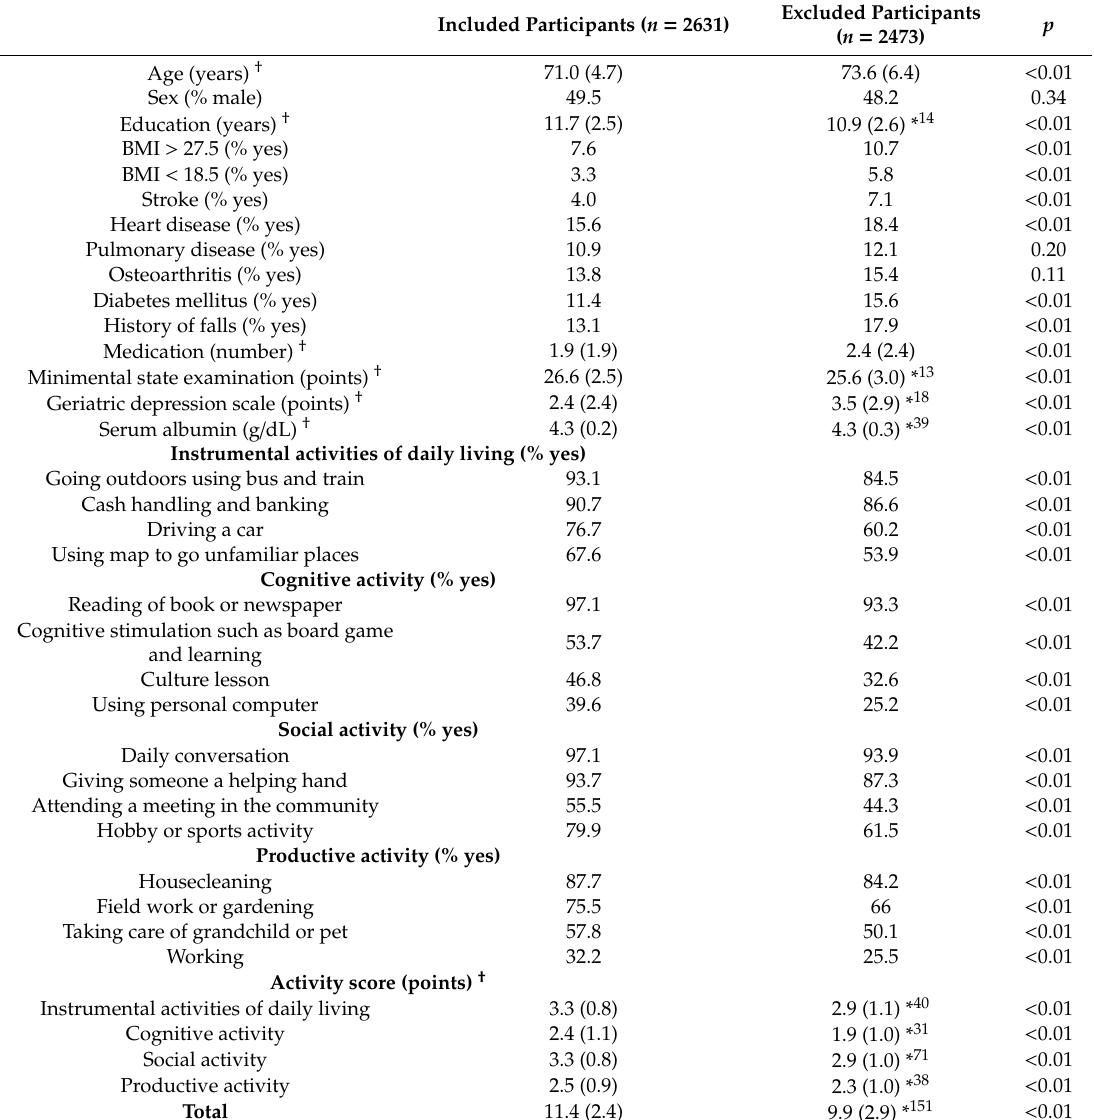
Table 1. Baseline characteristics of the included and excluded